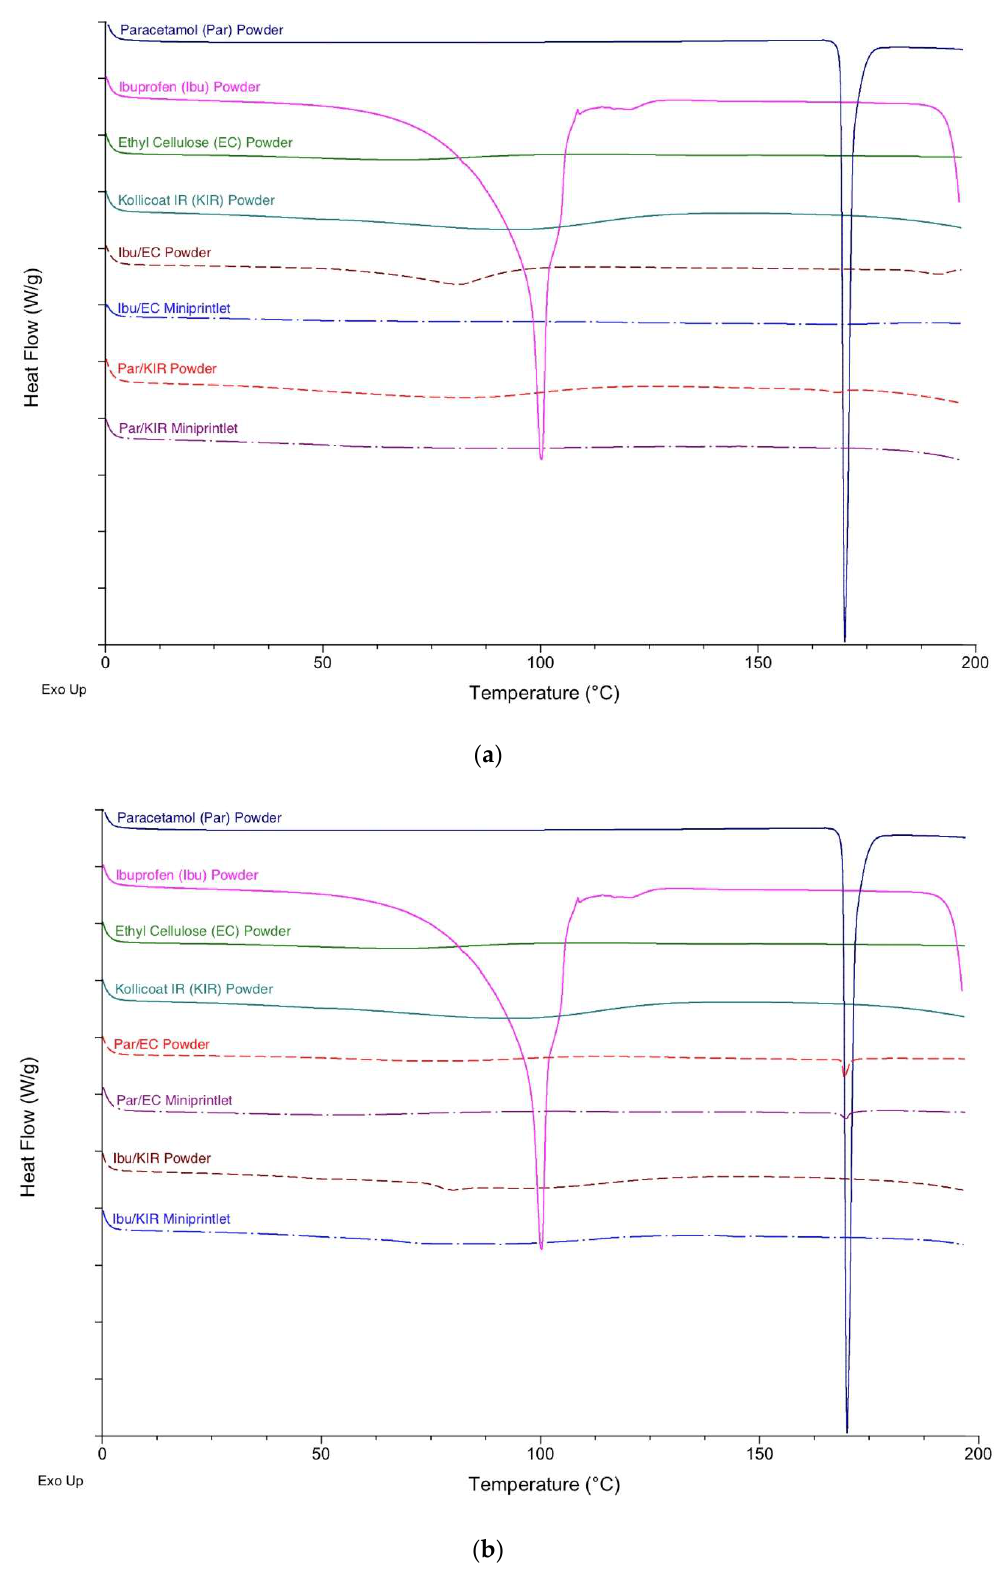
Figure 3. Differential scanning calorimetry (DSC) thermograms of the pure drugs, polymers and powder mixture prior to printing and the miniprintlets used in ( a ) Con A and ( b ) Con B of the dual miniprintlets.